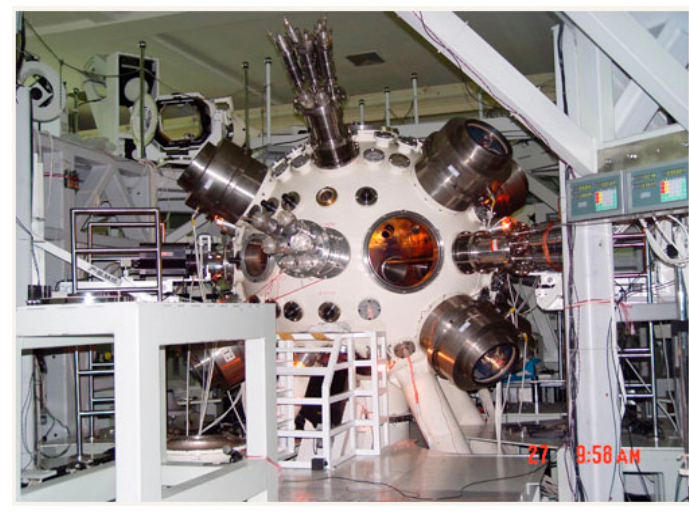
Figure 1. The ICF experimental facility.